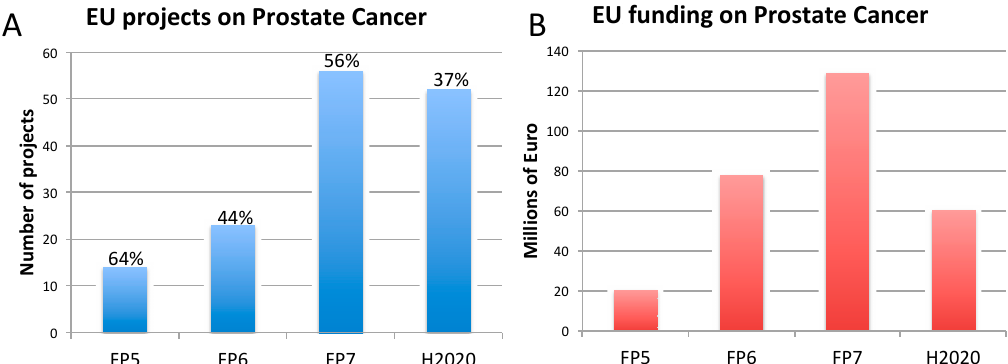
Figure 3. Number of EU-funded projects ( A ) and overall funding (in millions of euro) ( A ) allotted on prostate cancer-related research across Framework Programme (FP) 5, FP6, FP7 and Horizon 2020 (H2020). The percentages indicate the proportion of projects within a Framework Programme involving also the use of non-human animal models. Data were obtained from CORDIS [128], considering objective, reporting, and results sections, to assess whether non-human animal models were accounted for. FP7 and H2020 data were obtained using the EC CORDA database (H2020 data, as of 15 May 2019). As H2020 was still ongoing at the time of this analysis, H2020 data are not complete.